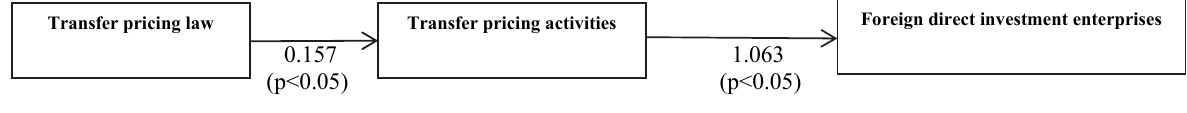
Fig. 2. Model estimation